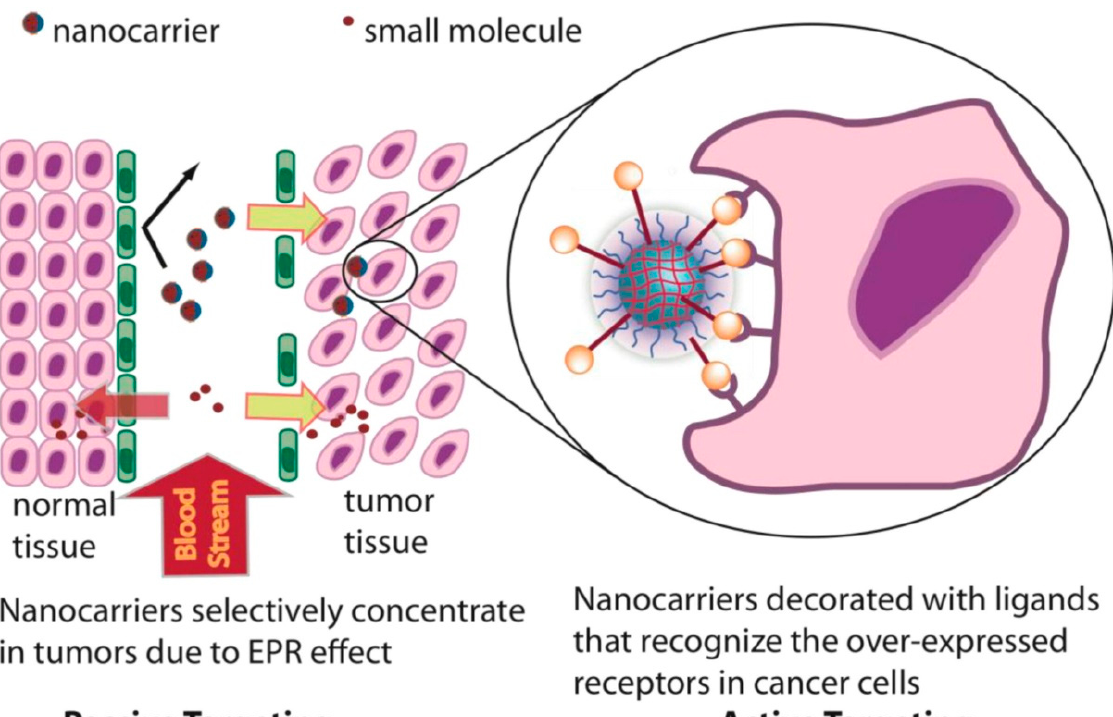
Figure 5. The EPR effect representing passive targeting mechanism and ligand functionalization representing active targeting mechanism [119].